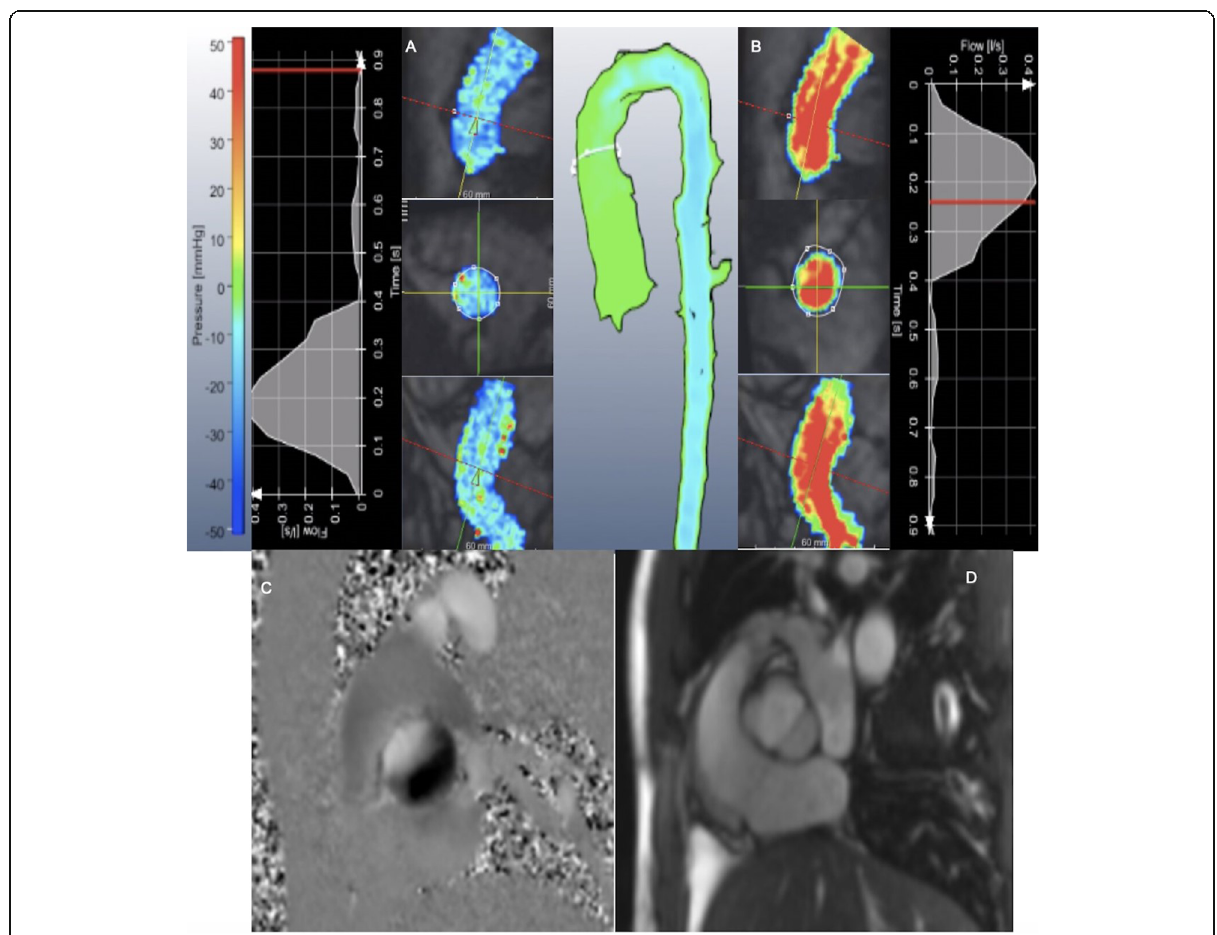
Fig. 2 Assessment of flow was performed using the 4D-flow software. Once ROI was fully defined for each time step throughout the cardiac cycle, the acquired data were fully processed for final